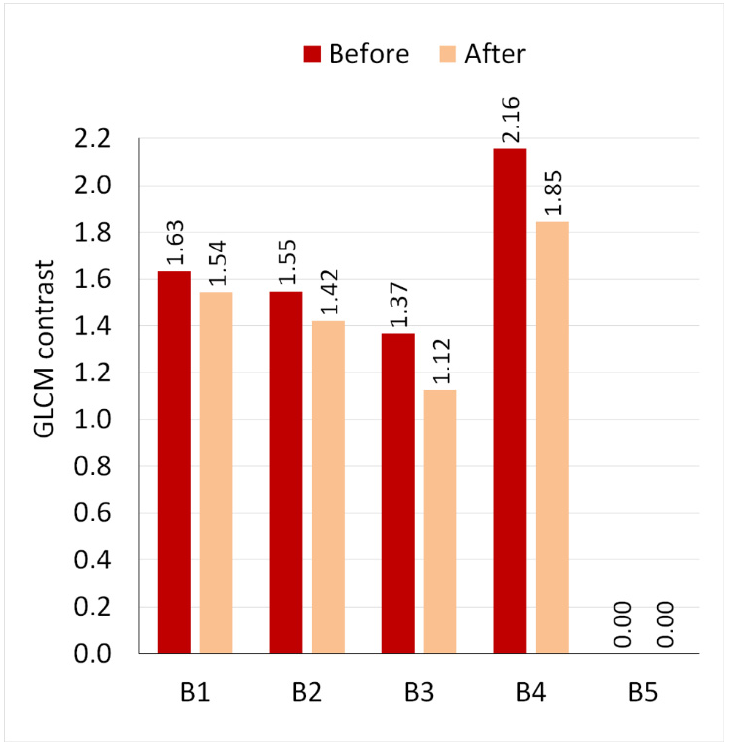
Figure 11. Contrast in GLCM analysis before and after laser application .